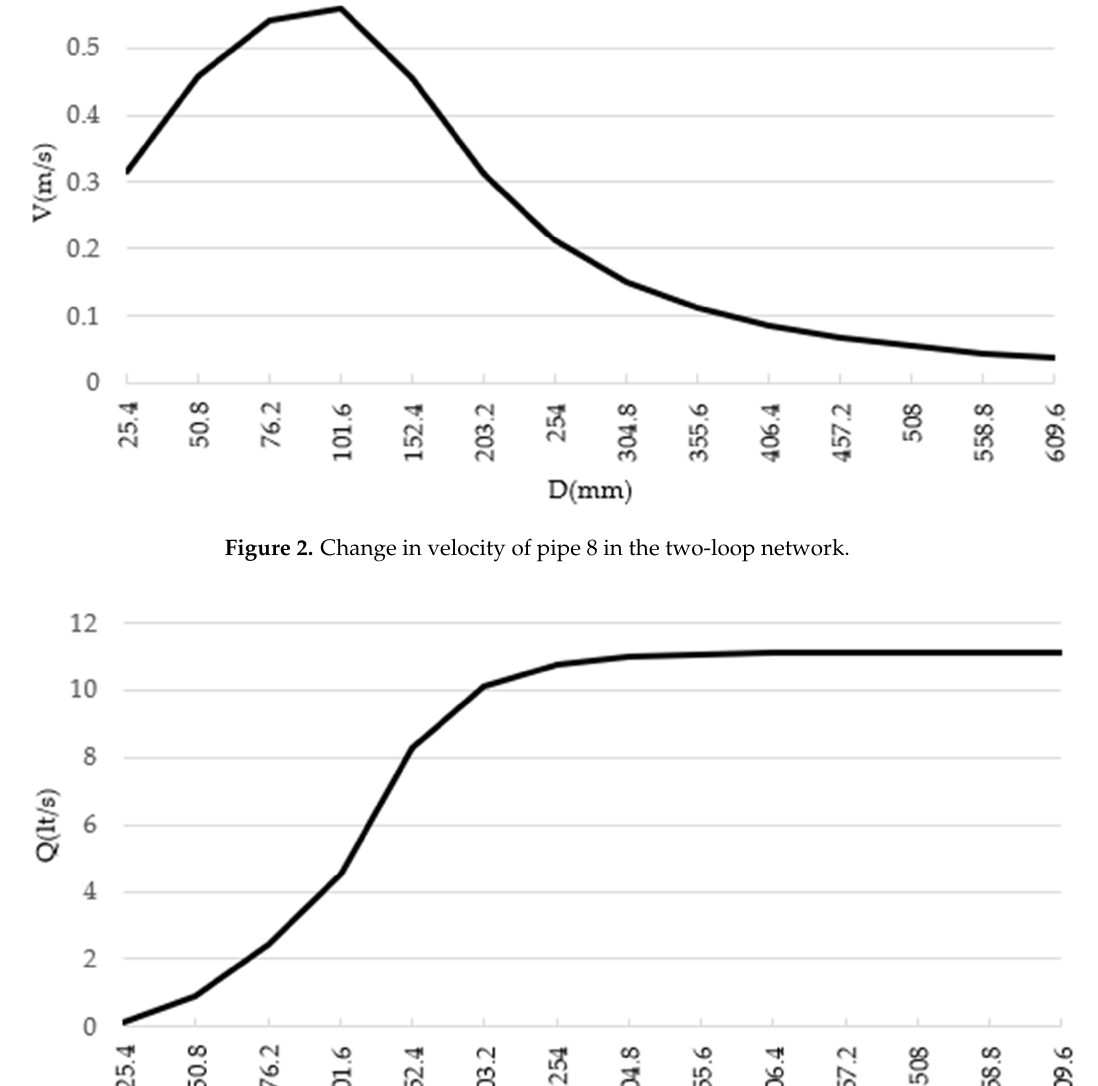
Figure 2. Change in velocity of pipe 8 in the two-loop network.